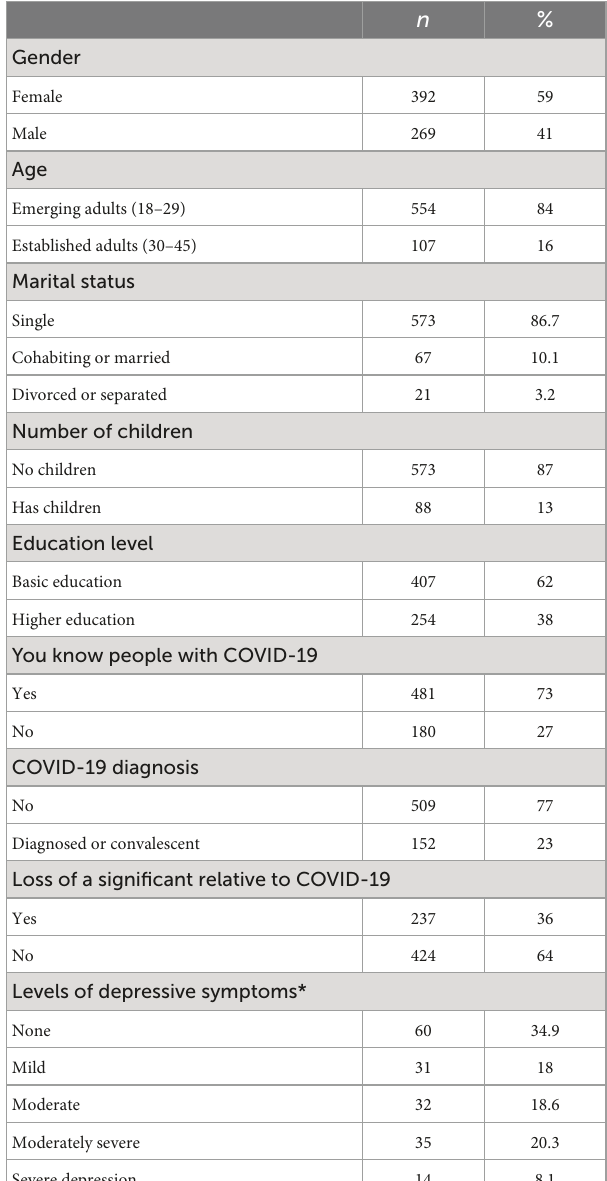
TABLE 1 Sociodemographic characteristics of the Peruvian sample ( n =